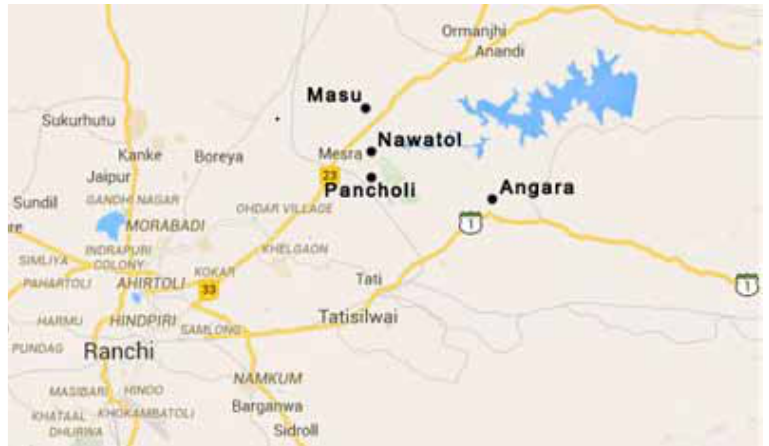
fig. 9. location of 4 study villages near ranchi Source: Compare Infobase ltd.